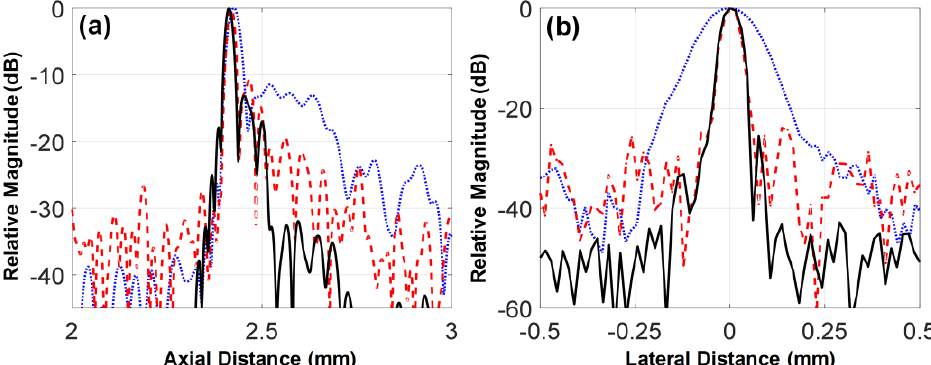
Figure 11. ( a ) Axial and ( b ) lateral beam profiles measured using a 25-μm wire located at the focal depth of the transducer, i.e., 2.5 mm. The dotted, dashed, and solid lines indicate the beam profiles obtained from the envelope signals of the 35-MHz fundamental, 105-MHz fundamental, and third harmonic scanlines, respectively.